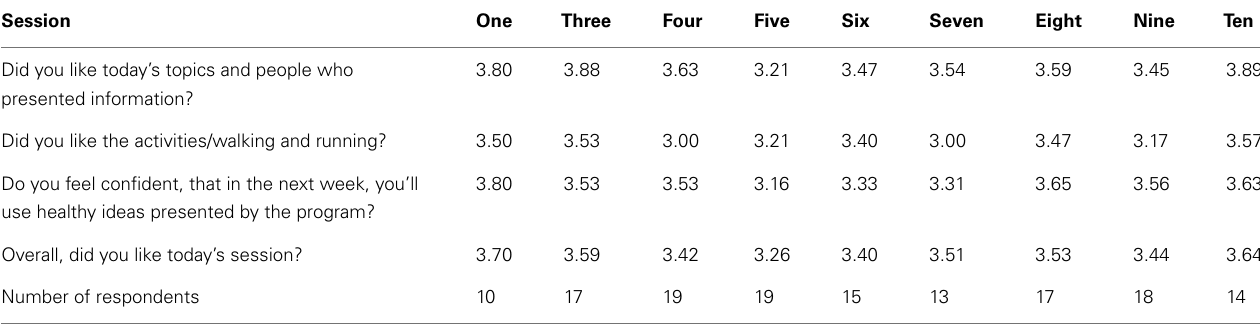
Table 3 |Youth responses to survey